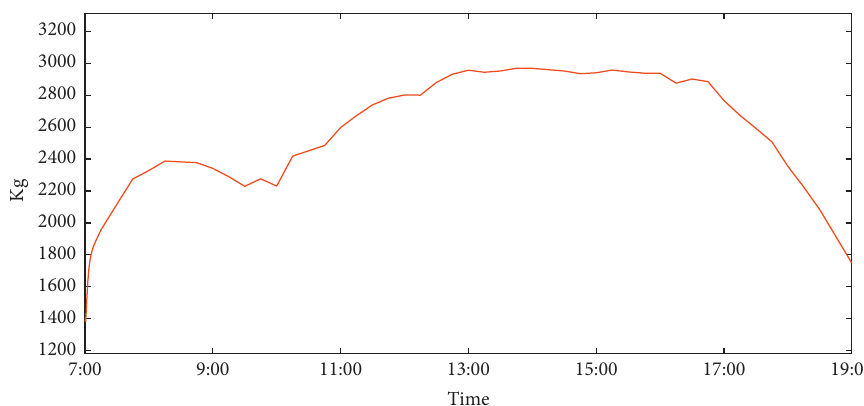
Figure 14: Change in the air supply volume of the